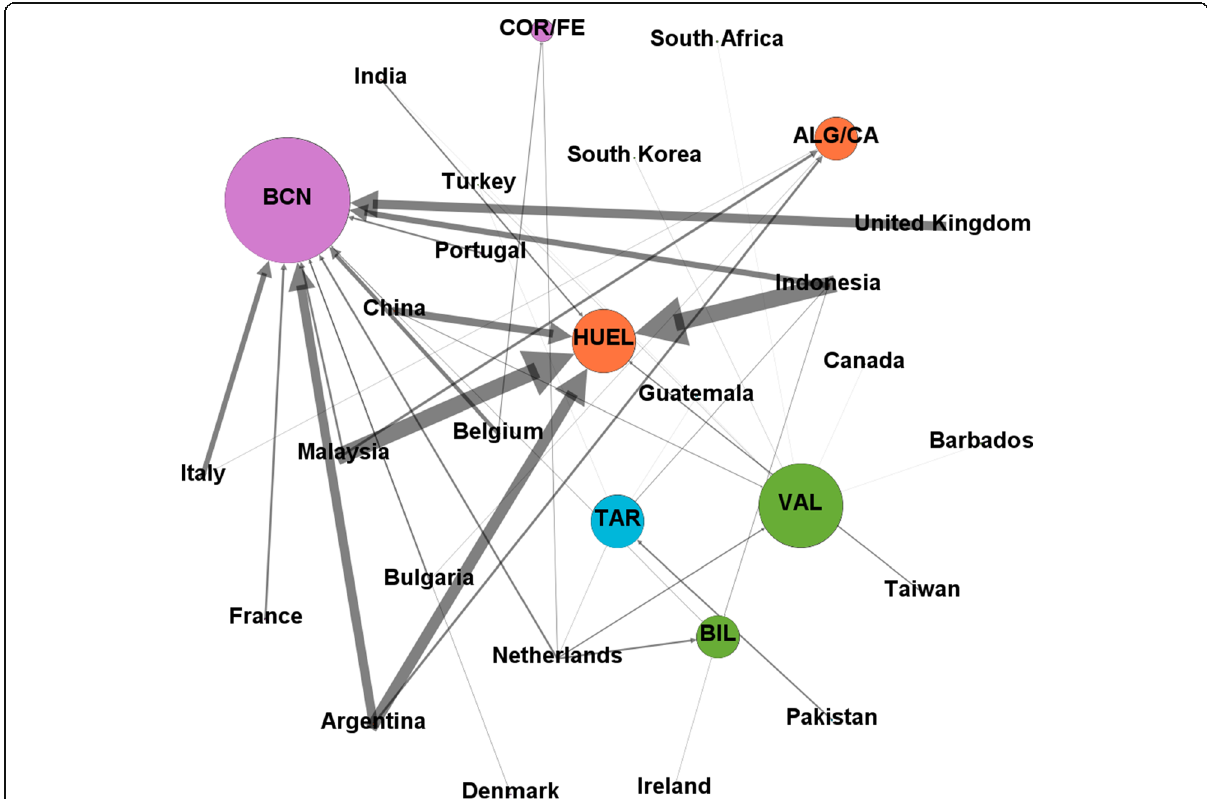
Fig. 5 Main import links for biofuels in 2019. Nodes and arrows are proportional to the degree of the node and the weight of the link respectively. Nodes in the same community are represented with the same